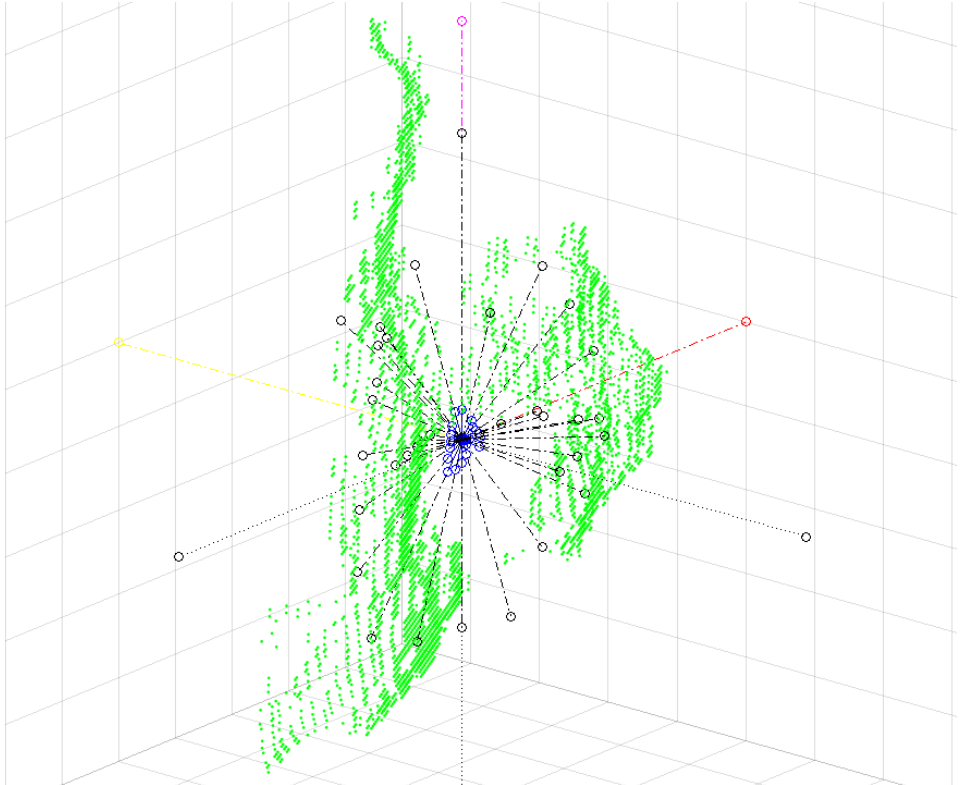
Figure 4. An MSL sign for the letter A, normalized in translation, scale, and rotation, showing the principal axes. The positive Y axis is shown in magenta, the positive X axis in red, and the positive Z axis in yellow. The average distance features in each spherical sector are shown in black, and the probability for each spherical sector is shown in blue.